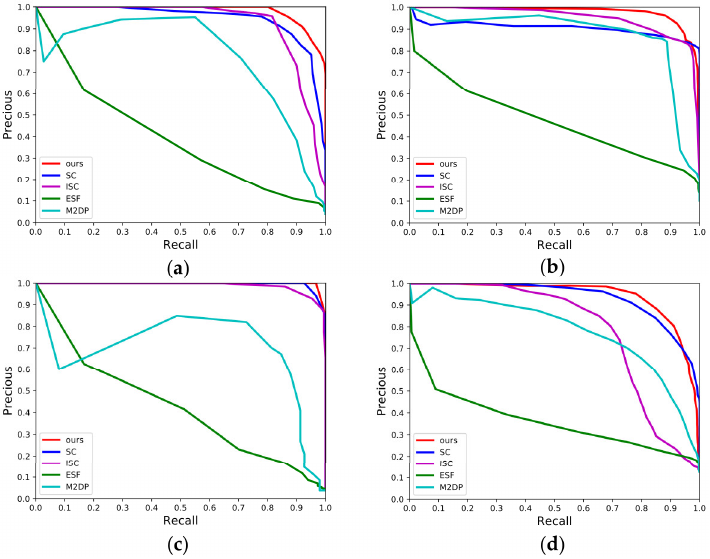
Figure 16. P-R curves of different methods over the campus dataset. ( a ) School-01; ( b ) School-02; ( c ) School-03; ( d ) School-04.